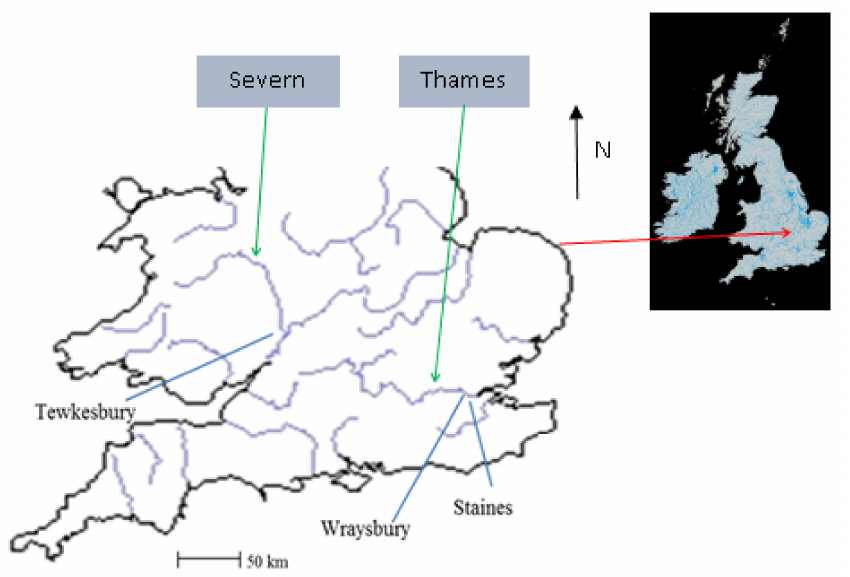
Figure 2. Locations of the 3 study sites in southern England, at Wraysbury (51.5 ◦ N, 0.6 ◦ W), Staines (51.4 ◦ N, 0.5 ◦ W) and Tewkesbury (52 ◦ N, 2.2 ◦ W) (main rivers in